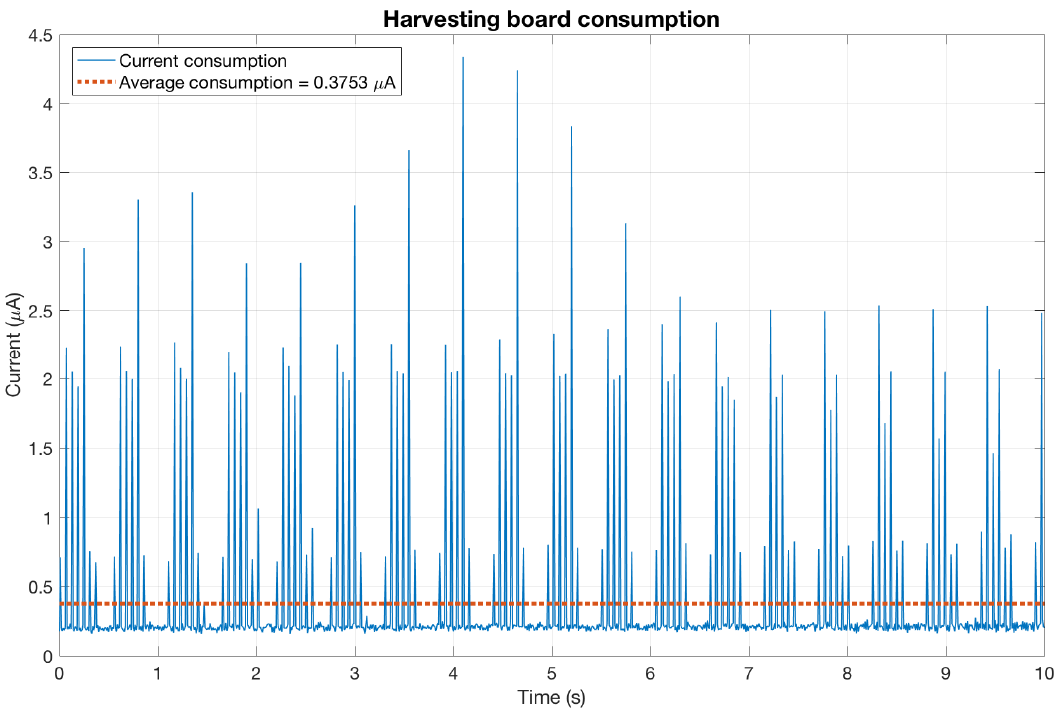
Sensors 2020 , 20 , x FOR PEER REVIEW Figure A3. Detailed consumption for the energy harvesting subsystem. Figure A3. Detailed consumption for the energy harvesting subsystem.